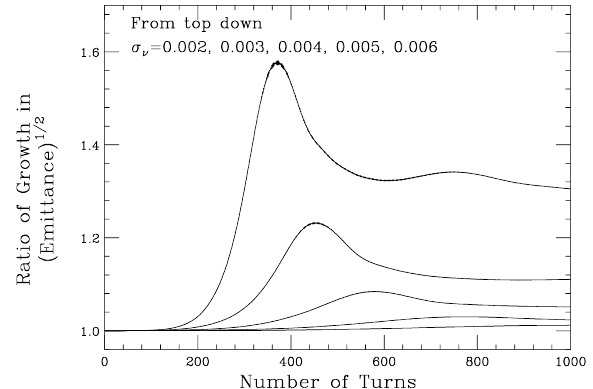
FIG. 18. Total growth of the 4-cm bunch within the 1000 turns in the presence of an amplitude dependent tune shift, such as provided by an octupole. The maximum growths are 1.23, 1.58, 1.08, 1.03, and 1.012, respectively, for rms tune spread (cid:1) 0.002 , 0.003, 0.004, 0.005, and 0.006. An average of s n b betatron function of (cid:8) b (cid:9) (cid:1) 20 m has been